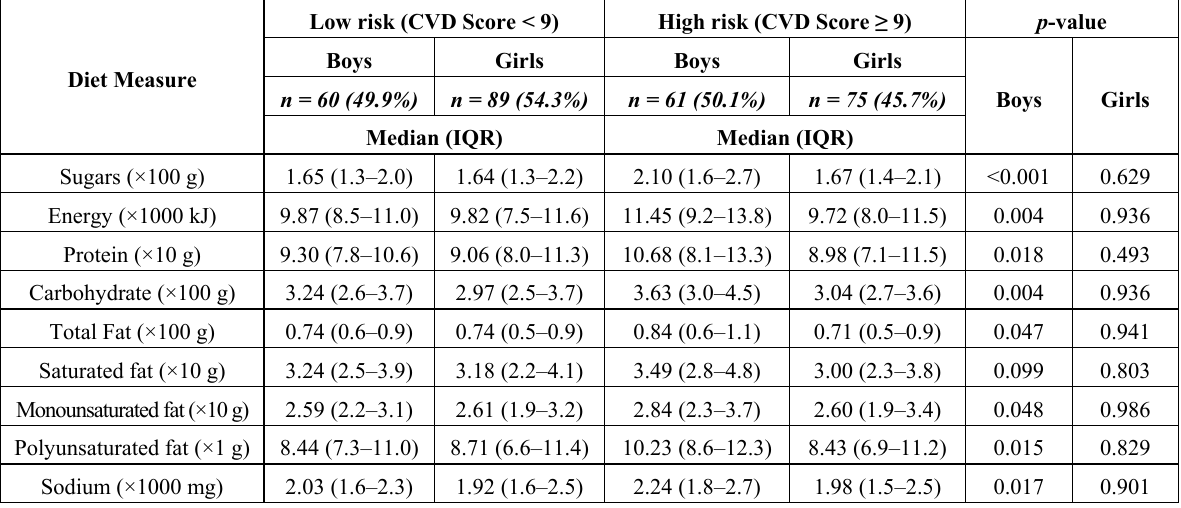
Table 4. Median and IQR of dietary measures by CVD risk score category (<9 and ≤9) and